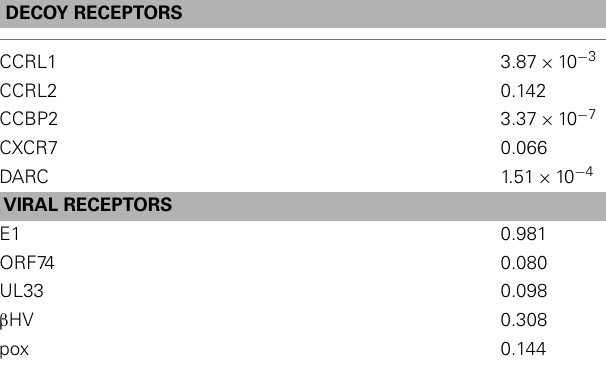
Table 3 | Results of t